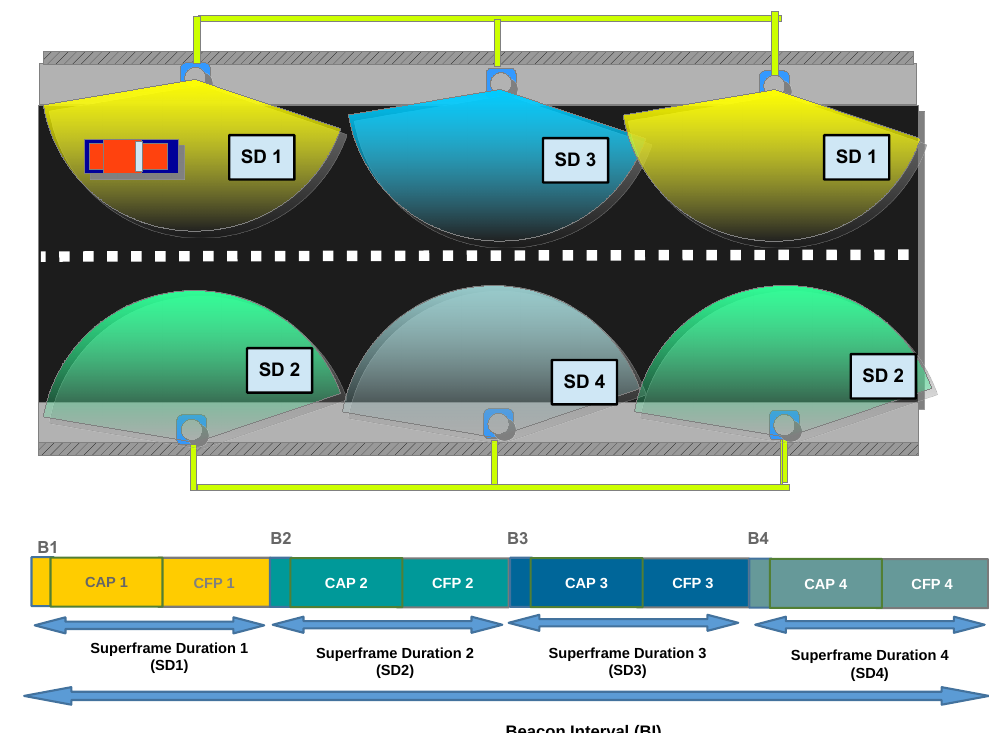
Figure 6. Cells distribution over the evaluation scenario ( top ), and cells distribution on the superframe structure ( bottom